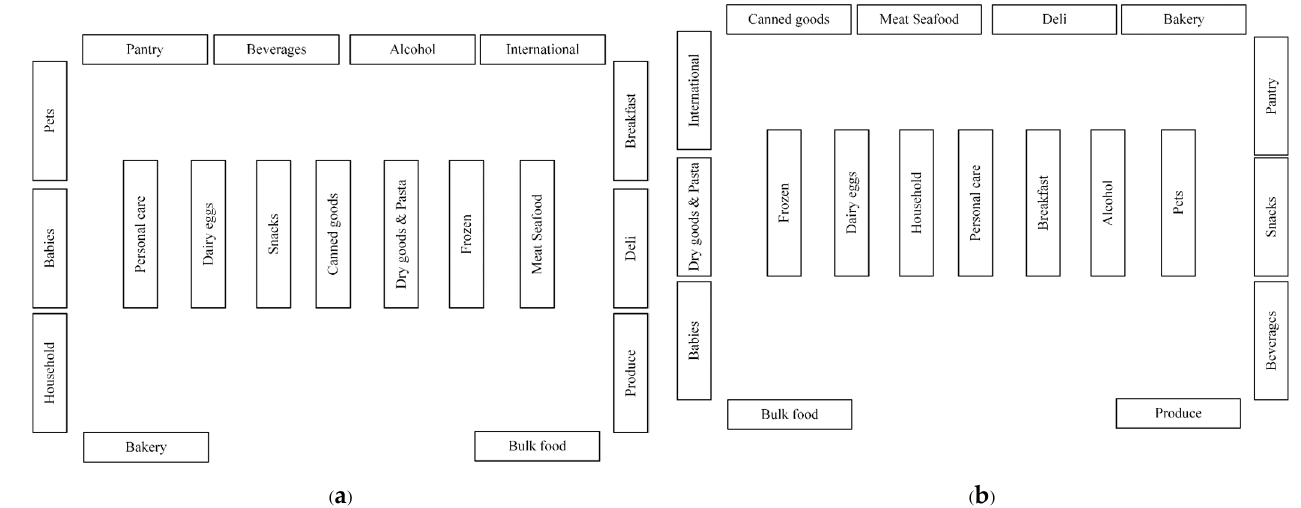
Figure 4. Product layouts: ( a ) the original product layout; ( b ) the proposed product layout. Table 12. Comparison of the profit volume and total closeness rating. Table 11. Profit volumes, total closeness rating, and execution time for the three algorithms.